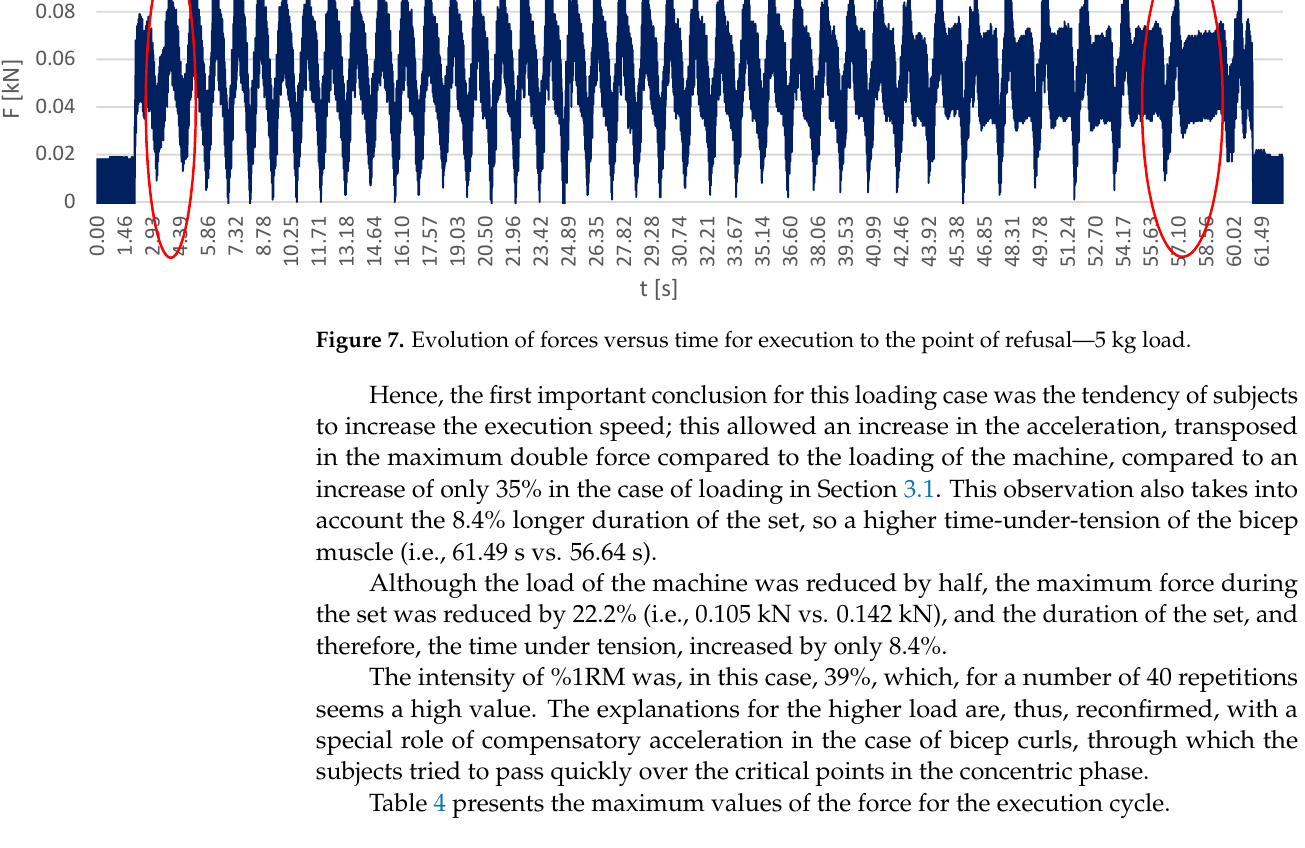
10 of 17 Table 3. Paired ‐ samples test: pair R24_Fmax–R2_Fmax. M